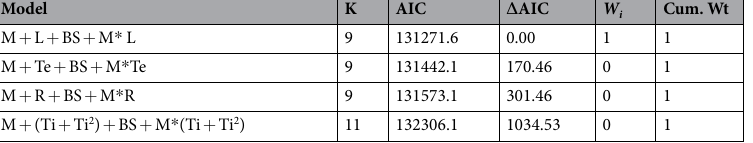
Table 2. Models explaining variation in foraging effort (Average hourly distance travelled by individuals outside of the core nesting area (10% kernel estimate)). Model selection based on corrected Akaike Information Criterion scores (AIC). Light level measured as average hourly solar radiation (W/m 2 ). Rain = average hourly rainfall, Temperature = average hourly temperature and Time = time (and its quadratic term). K denotes the number of parameters (K), change in AIC relative to the highest ranked model ( Δ AIC), AIC weight ( W i ). Results show the top ranked model (with Δ AIC < 2, shown in bold) included the term light level and its interaction with morph and held 100% of the weight. Morph = M, Light = L, Breeding stage = BS, Time = Ti, Temperature = Te, Rain = R.